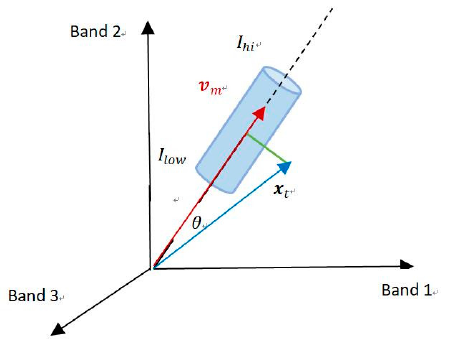
Figure 1. Visualization of the judging criteria (a) brightness bounds and (b) spectral distortion.